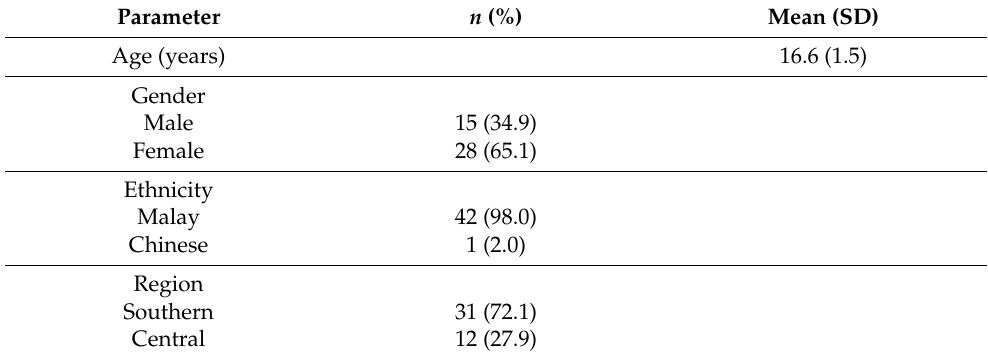
Table 1. Sociodemographic profiles of adolescents in needs assessments ( n = 43).